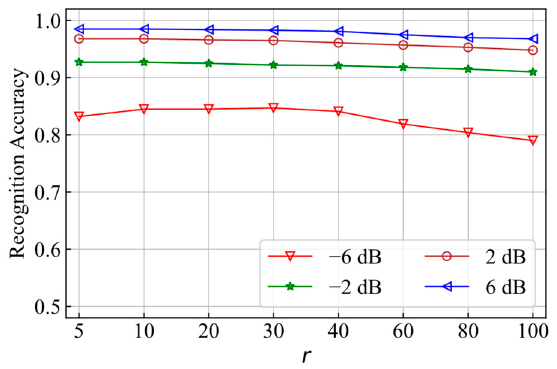
Figure 7. Comparison of recognition accuracy for different r values .